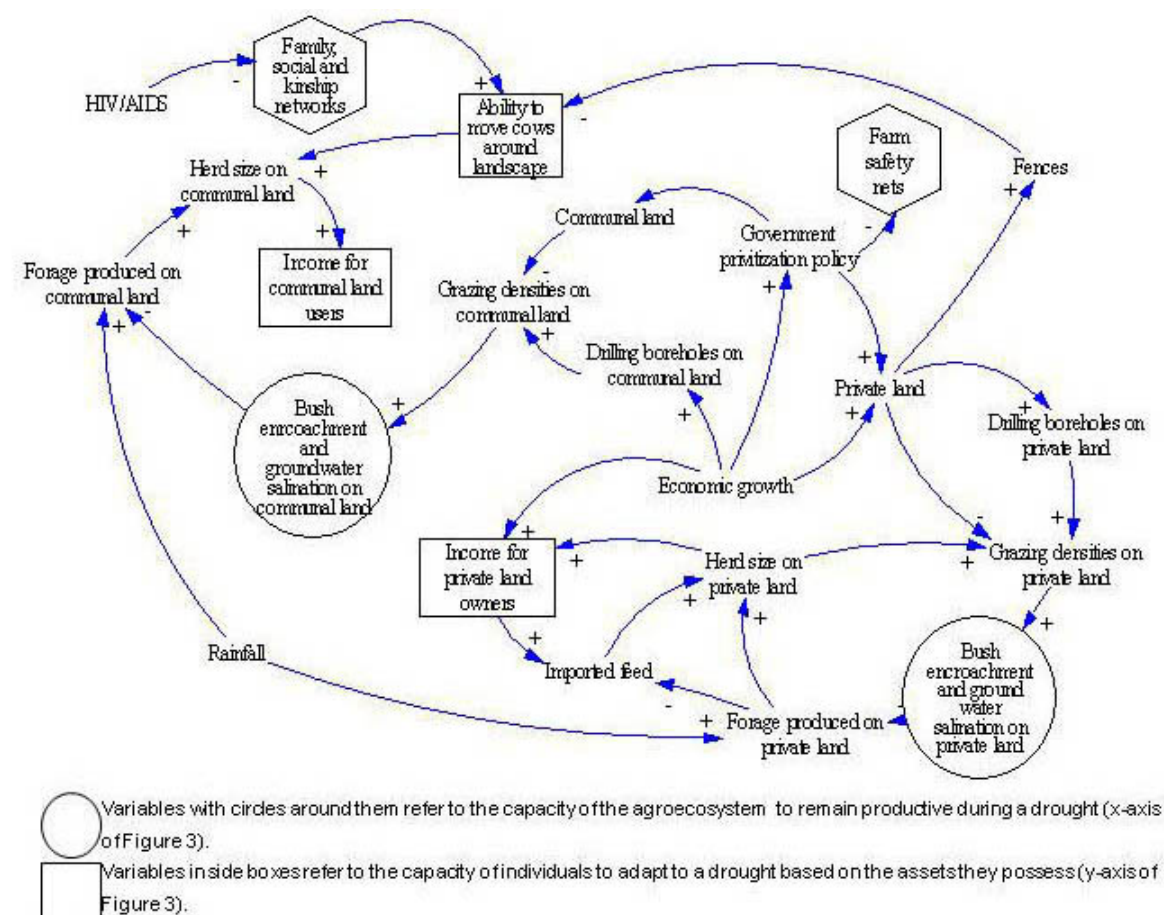
Fig. 2 . Dynamic systems model of the agropastoral food system of southern Botswana. Each variable in this model emerged from expert opinions, and the sign next to each arrow (+ or -) indicates whether the relation is positive or negative as classed from interviews and/or available data